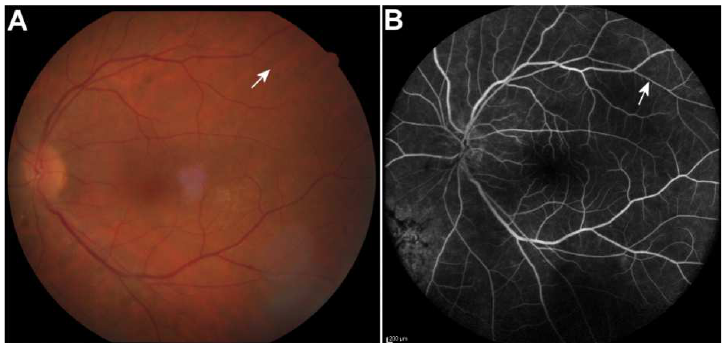
Figure 3. The Kyrieleis plaques faded with a few persisting at 3 months after the initiation of treatment in color fundus photo ( A ) and fluorescein angiography ( B ) of the left eye (arrows). Scale bar 200 µm.